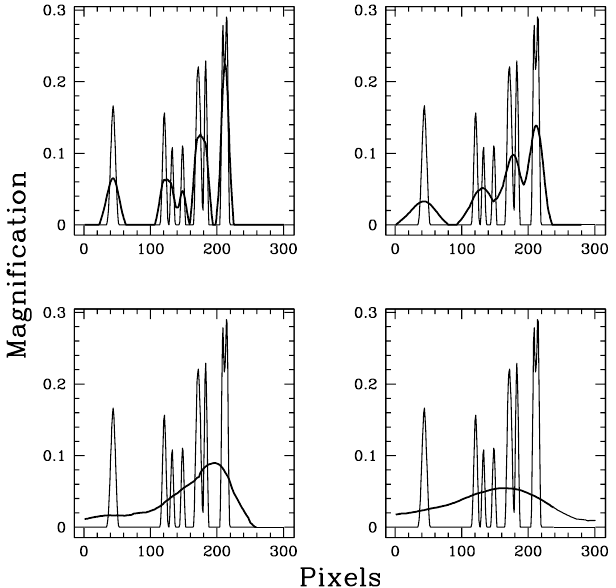
Fig. 2. The light curve of a source of the 0.1 light-day size (thin line) compared with light curves of sources of the sizes 0.5, 1, 2 and 5 light-days (thick line). = P (II), we obtain P (I j 7) = 0.75 and P (II j 7) = 0.25. If we assume that